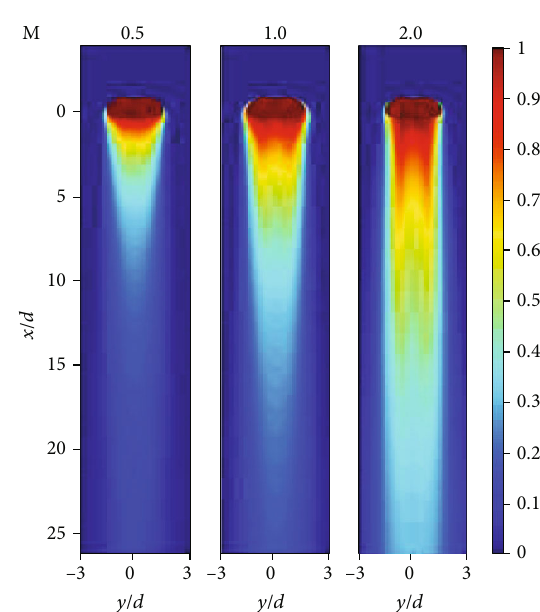
Figure 13: CFD contours of θ = 7 ° .